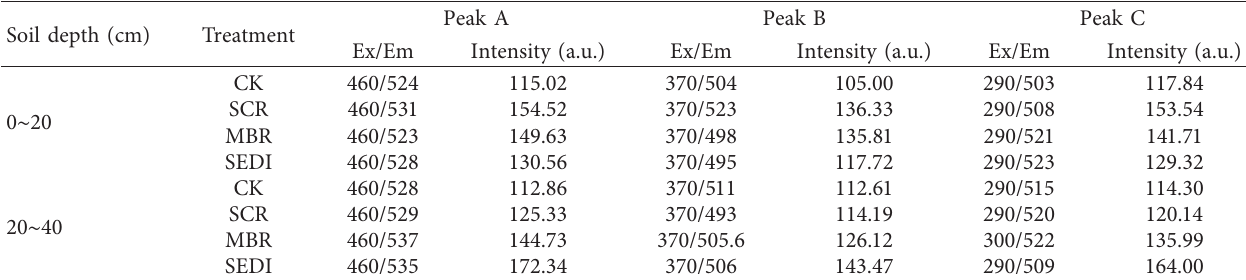
Figure 3: Fluorescence spectra of HA in different maize returning methods on subsoil. Note. CK: no straw application; SCR: straw mulching; MBR: straw deep ploughing; SEDI: straw enrichment and deep incorporation. (a) Subsoil: CK. (b) Subsoil: SCR. (c) Subsoil: MBR. (d) Subsoil: SEDI. Table 4: Excitation (Ex)/emission (Em) wavelength and fluorescence intensity (FI) of peaks in humic acid after different corn straw return